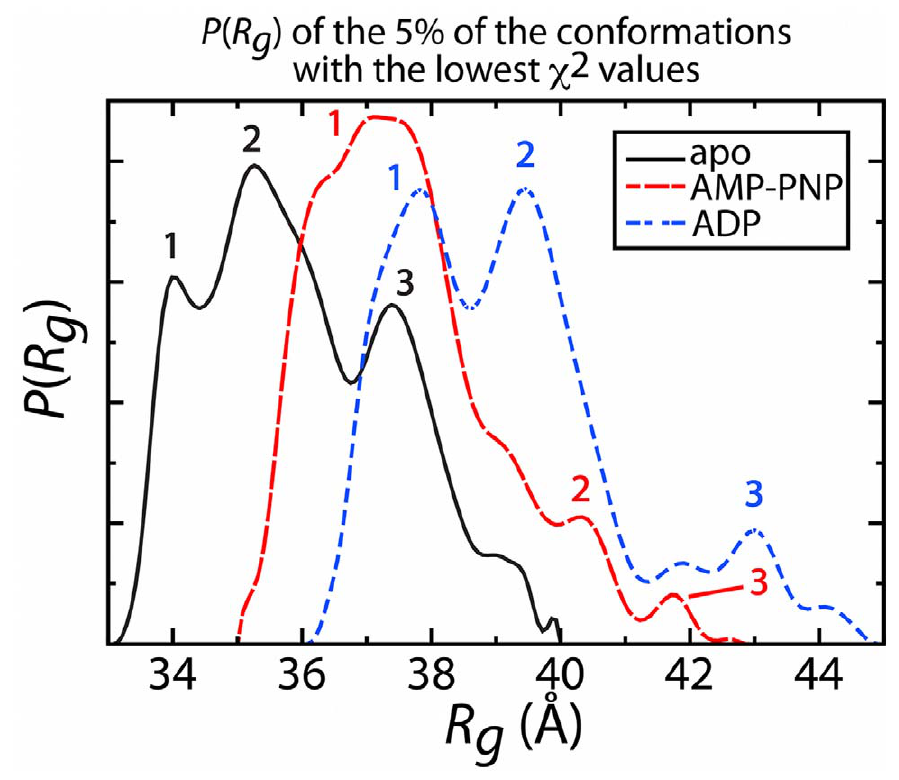
Figure 2. The probability of R g (P(R g )) of the 5% of conformations with the lowest x 2 values from the SBM simulations. Apo Csk appears in black, AMP-PNP bound Csk appears in red, and ADP bound Csk appears in blue. The three most prominent populations, from which representative conformations were selected for ensemble analysis, are highlighted for each state.